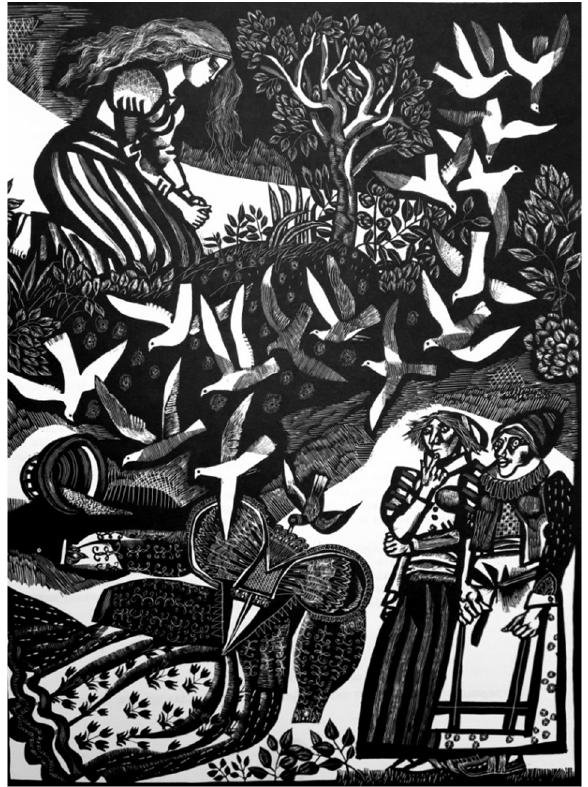
Figure 3. Illustration of The Brothers Grimm, Fairy Tales (Cinderella), 1985. Illustrated by Rumen Skorchev, Sofia: Narodna Mladezh.